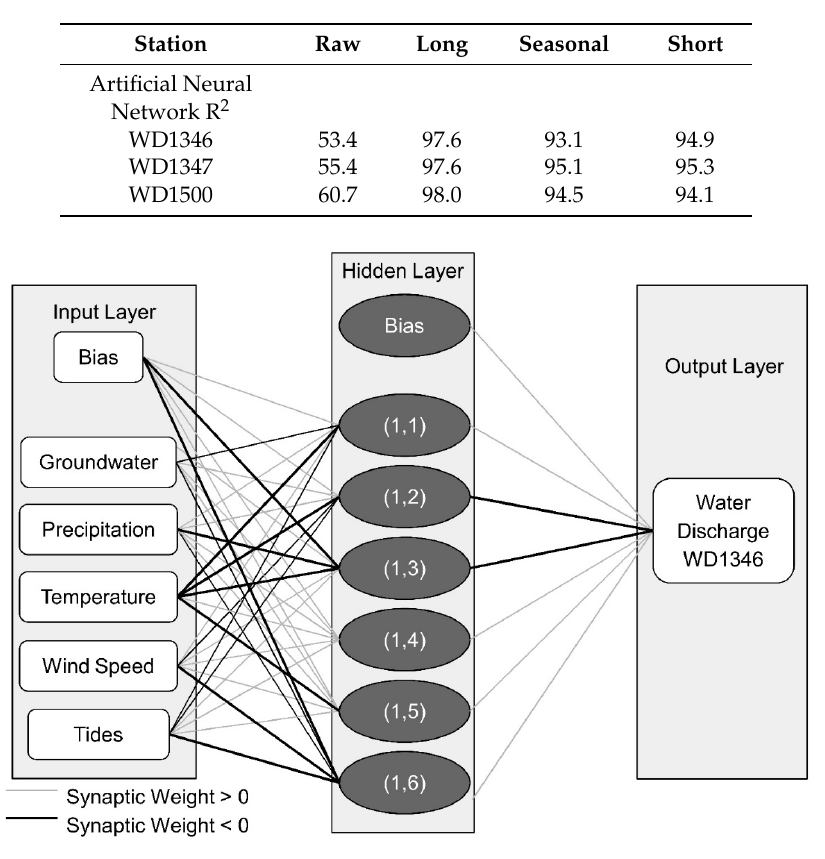
Figure 5. The feedforward artificial neural network of the raw data from the USGS station WD1346 using a hidden layer transfer function of hyperbolic tangent and an output layer for the prediction of water